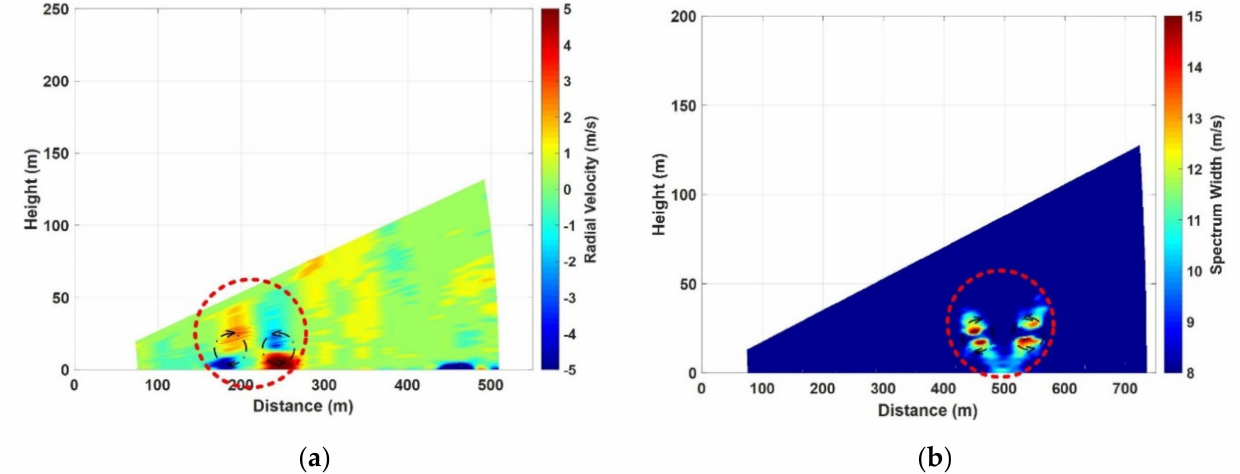
Figure 4. Wake vortex in PCDL RHI scans. ( a ) The radial velocity distribution for the take-off phase at MNA. ( b ) The spectrum width distribution for the landing phase at